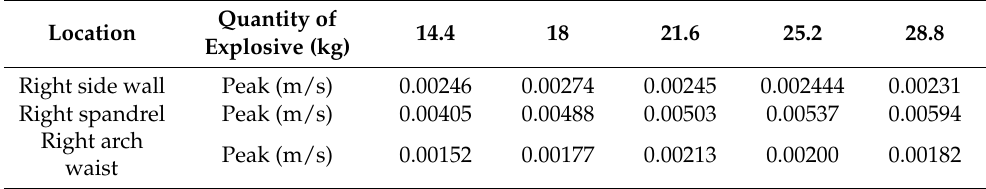
Table 7. Peak particle velocity and location with different explosive